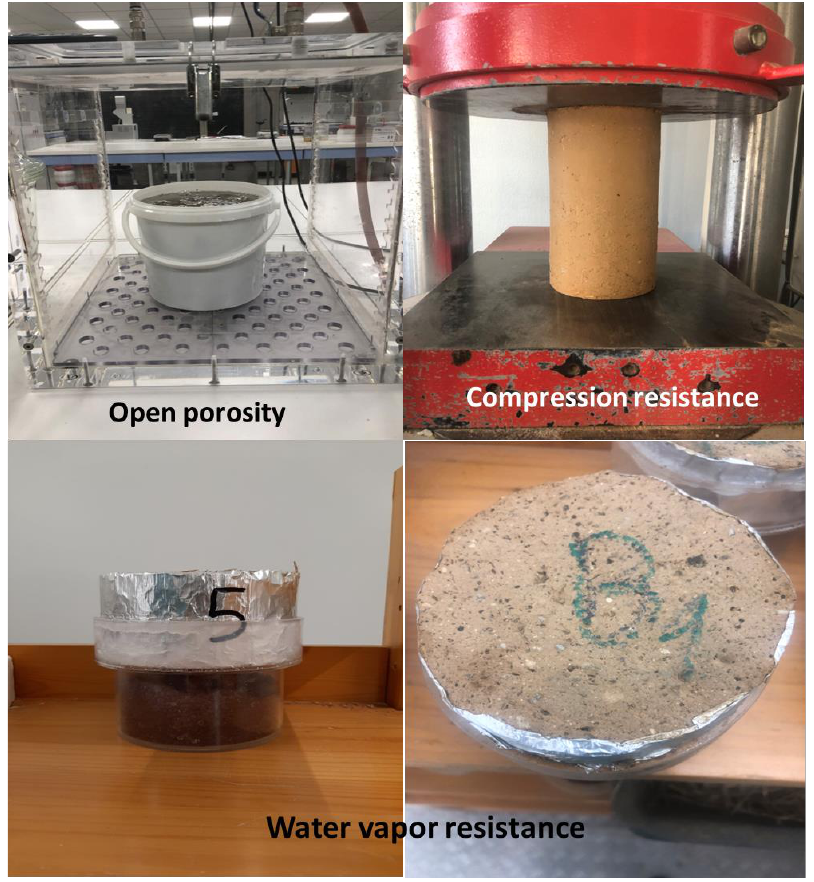
Figure 4. Porosity, mechanical, and water vapor resistances tests conducted in this study.